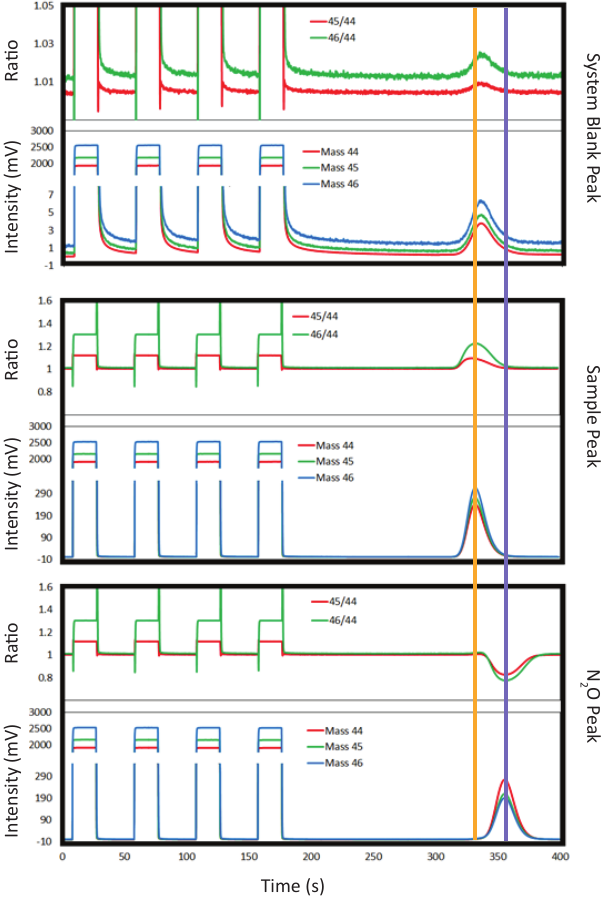
Figure 3. A visual comparison of the system blank peak (top), the sample peak (middle), and the N 2 O peak (bottom). During a nor- mal measurement, N 2 O is removed from the sample to avoid iso- baric interference with the CO-derived CO 2 masses. As a further precaution N 2 O and CO 2 are separated on the gas chromatograph where N 2 O peaks at ∼ 355s compared to CO 2 peaking at ∼ 330s. The mass ratio 45 / 44 and 46 / 44 traces show inverted compared to the CO 2 and are easily recognizable. The absence of a N 2 O signal shows that N 2 O is quantitatively trapped in the cryogenic trap and does not reach the IRMS. The mass traces (44, 45 and 46) shown are direct output from the ISODAT software. For the ratios 45 / 44 and 46 / 44, a value of 100mV was arbitrarily added to the signals in order to avoid artificial noise arising from the ratio of two small numbers.